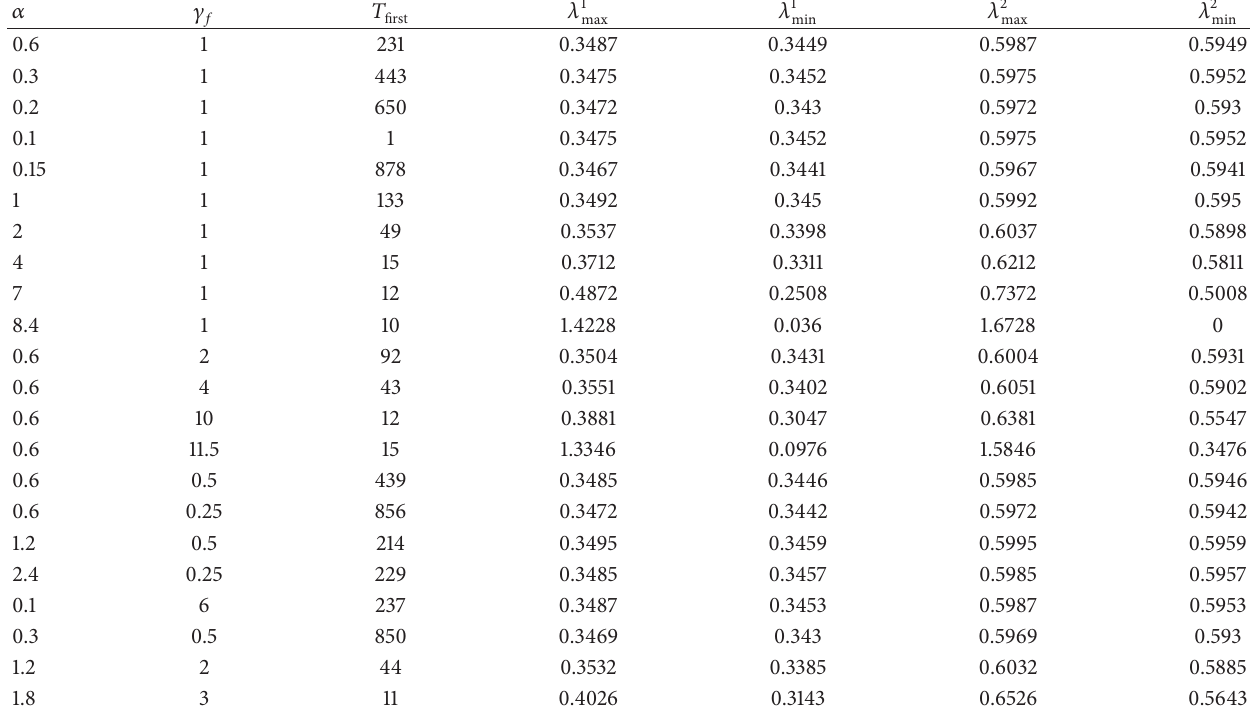
Table 1: The effects of amplitude factor and volatility factor on system